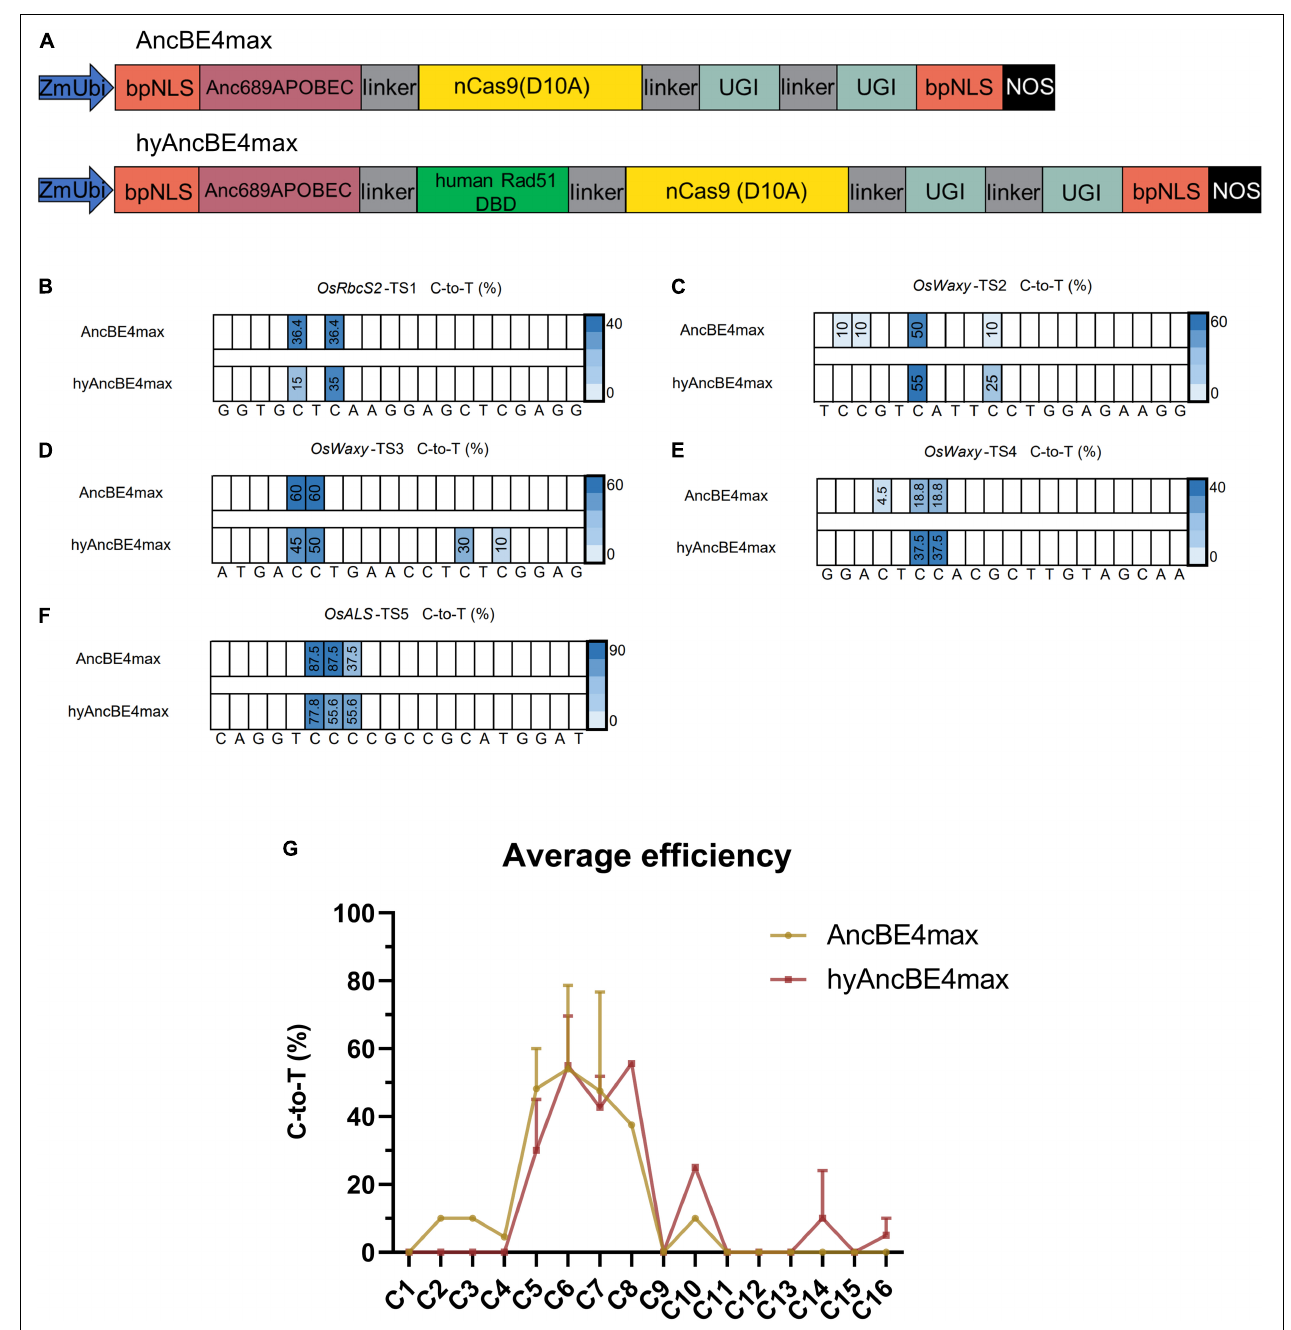
FIGURE 1 | Characterization of AncBE4max and hyAncBE4max in rice. (A) Schematic structures of AncBE4max and hyAncBE4max. The human Rad51 DBD was synthesized using a plant optimized code and cloned into AncBE4max (Wang et al., 2019) to form hyAncBE4max. ZmUbi, maize ubiquitin-1 promoter; bpNLS, bipartite nuclear localization signal; nCas9(D10A), nickase Cas9 with D10A substitution; UGI, uracil glycosylase inhibitor; NOS, NOS terminator. (B–F) C-to-T conversions in five target sites using AncBE4max or hyAncBE4max. (G) Average C-to-T editing efficiency for AncBE4max and hyAncBE4max based on all five target sites. Data are means ±